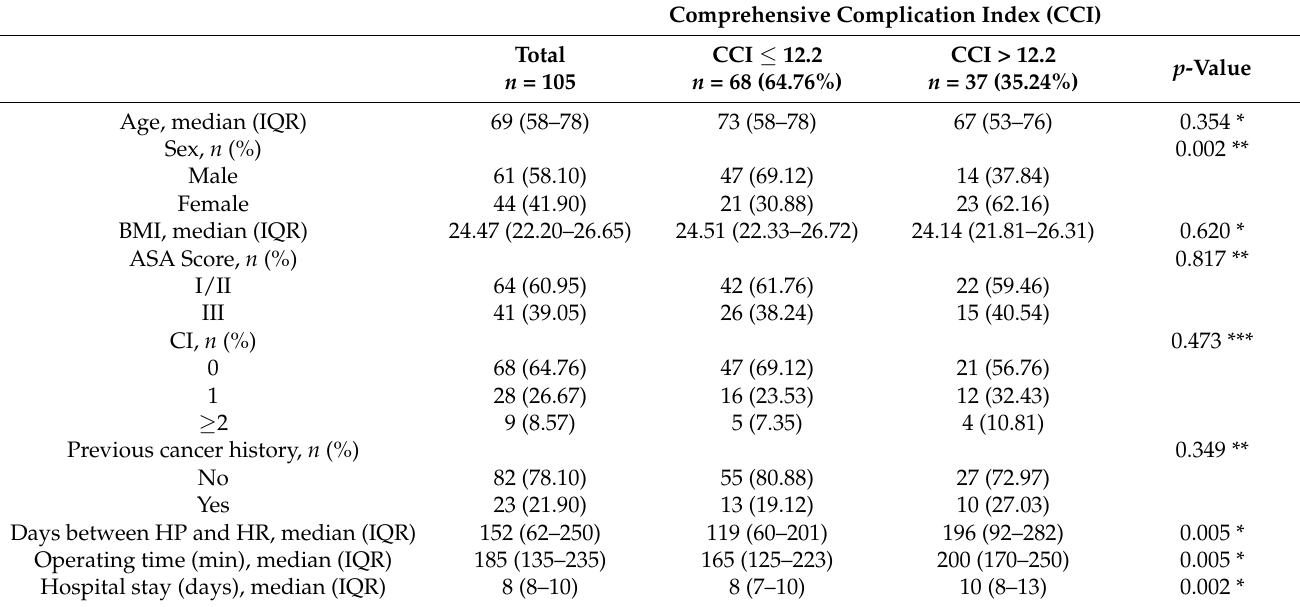
Table 3. Characteristics of the sample stratified on of the CCI ≤ 12.2 and >